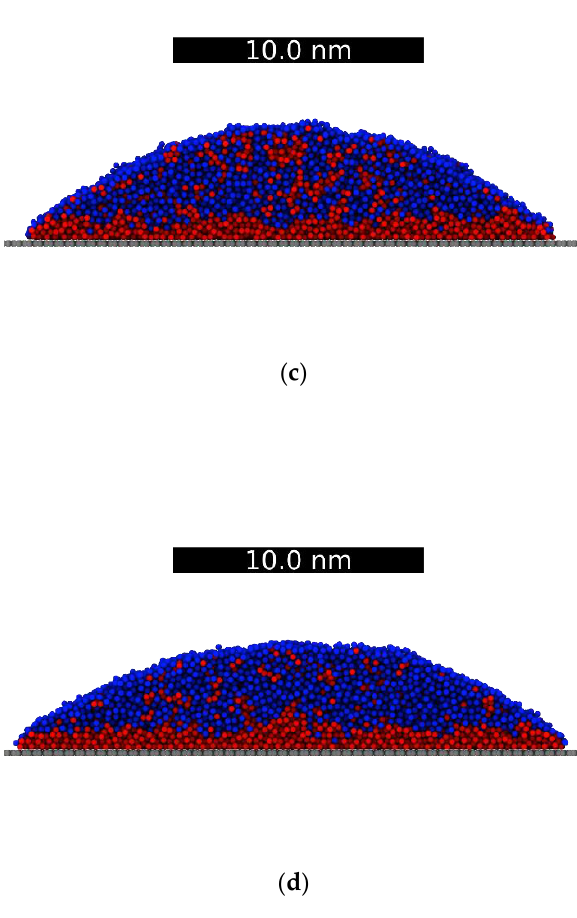
Figure 9. ( a ) 2000 K droplet deposited on one-layer of graphite. ( b ), ( c ), and ( d ) a cross-section snapshot at 2000, 1800, and 1600 K, respectively. The scale bar in ( a ) corresponds to the length of the droplet. Color code: Ni, red; Ag, blue; and C, grey.